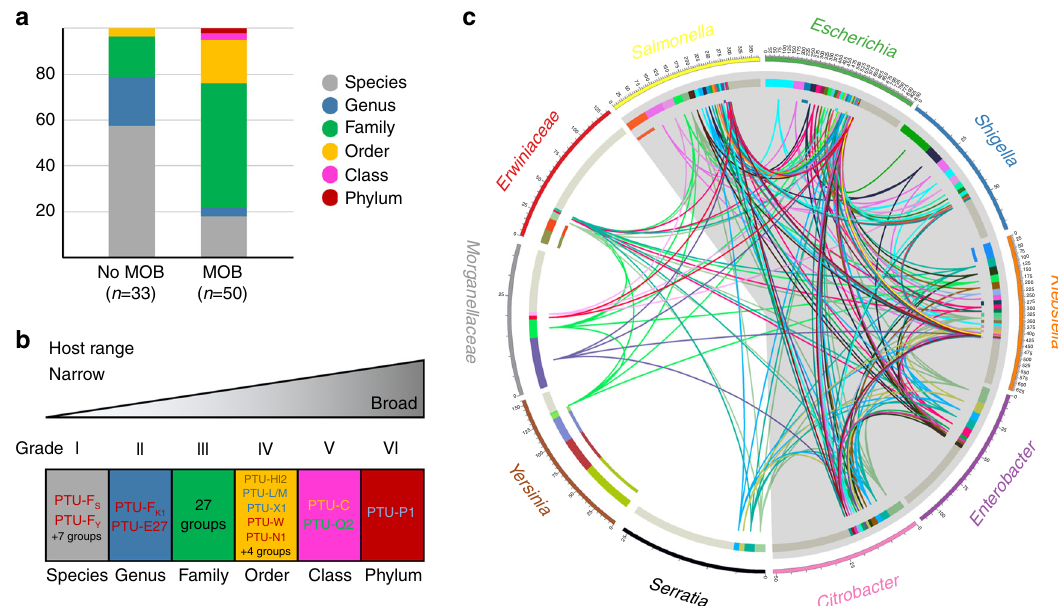
Fig. 5 PTUs of different host range delineate pathways for HGT in Enterobacterales . a The graph shows the host distribution of different PTUs. The distribution breath is the taxonomic depth between the two most distinct hosts in which that PTU is found. The left column shows percentages for nonmobilizable PTUs, while the right column shows data for mobilizable and conjugative PTUs. b Host range scale for mobilizable and conjugative PTUs from Enterobacterales , color-coded as in a . c Chord diagram showing the distribution of PTUs among the bacterial taxa shown in the outer rim of the diagram. Bars below each taxonomic group represent the total number of plasmids present in that taxon. Colored sectors indicate each of the mobilizable/ conjugative PTUs de fi ned in Fig. 4b. Inner ring is colored by PTU membership of plasmids. Whenever two bacterial taxa host plasmids from the same PTU, they are linked by an edge. This way, internal chords represent potential routes for plasmid-mediated HGT among different bacterial genera. Members of the Enterobacteriaceae family are